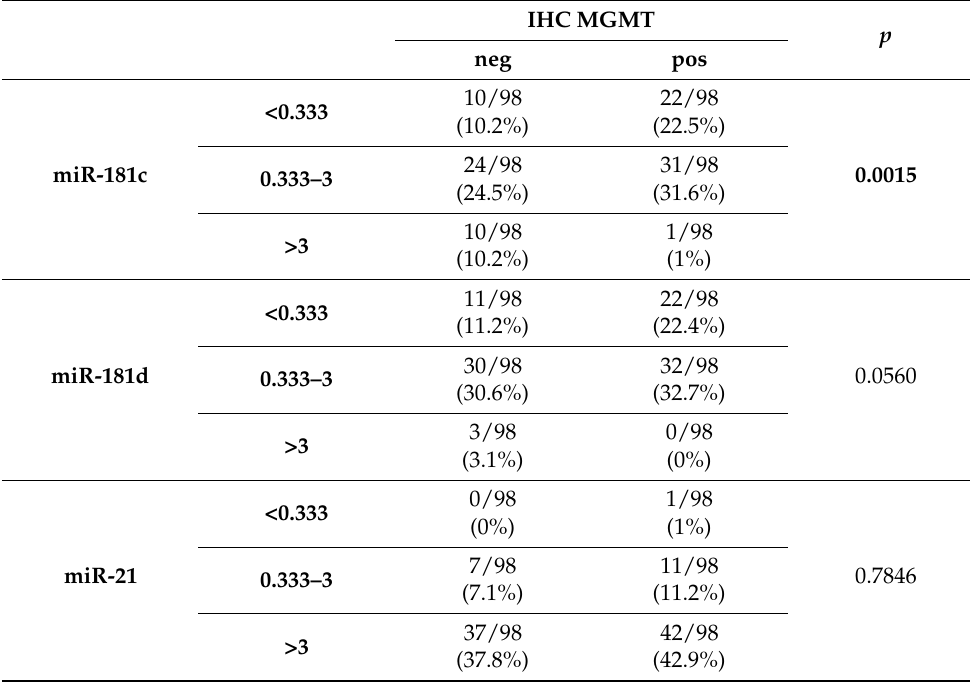
Table 3. MGMT IHC and miRNA bivariate